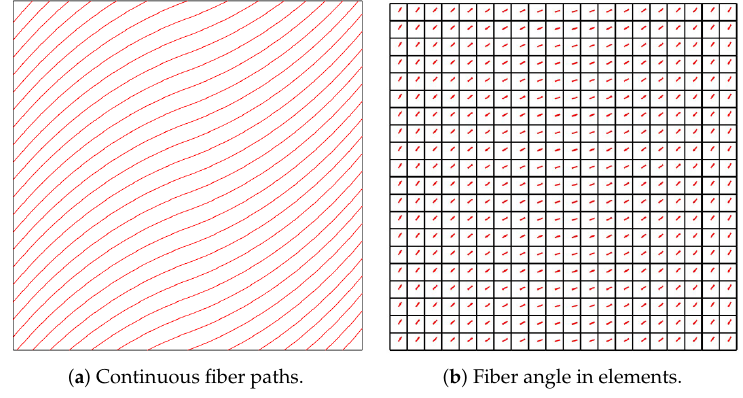
Figure 2. Modelling of tow steered (cid:104) 20,50 (cid:105)